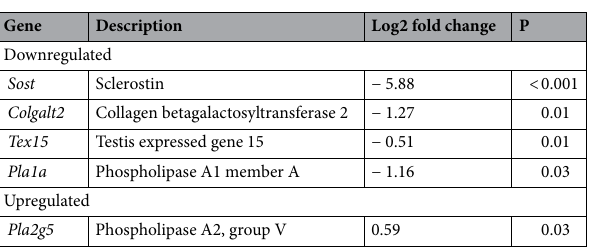
Table 1. List of differentially regulated genes in Jrt;Sost-ko mice compared to Jrt;Sost-het mice. P values are adjusted by the Benjamini–Hochberg procedure, as determined by Deseq. N = 4 mice per